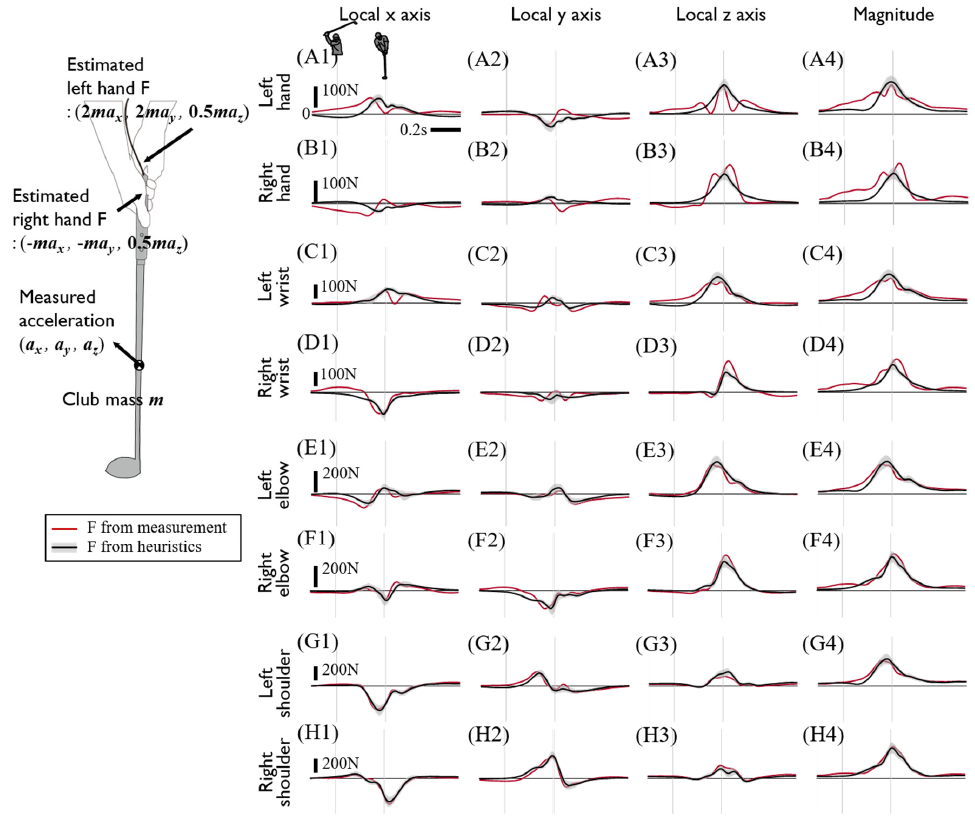
Figure 8. Calculated joint forces of the upper limbs using the measured internal grip force and torque or estimated hand-grip joint force and torque. Each row shows the joint forces of the left hand-grip joint ( A1 – A4 ), right hand-grip joint ( B1 – B4 ), left wrist ( C1 – C4 ), right wrist ( D1 – D4 ), left elbow ( E1 – E4 ), right elbow ( F1 – F4 ), left shoulder ( G1 – G4 ), and right shoulder ( H1 – H4 ), respectively. Each column shows the x , y , and, z values and the magnitude of joint force at the local coordinate of the proximal segment except for the hand-grip joint. The hand-grip joint force was analyzed using the club’s local coordinates. The black line with gray shading shows the joint force calculated from the estimated hand-grip joint force and torque, and the red line shows the joint force calculated from the measured internal grip force and torque. The forces act on the distal segment of each joint and are the averages of driver swing data pm all subjects. The two thin gray vertical lines indicate the backswing top and impact. The left picture briefly shows how to estimate the hand-grip joint force.